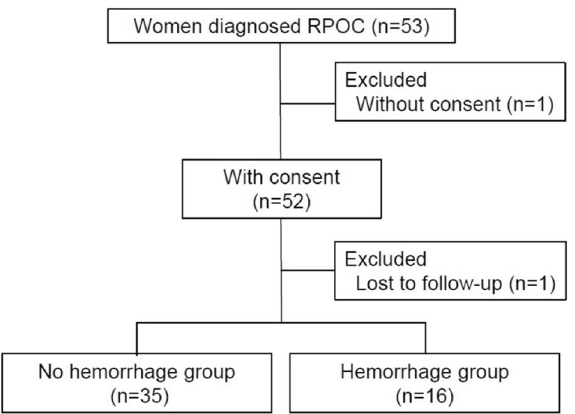
Figure 1. Patient flow chart. A total of 53 women diagnosed with RPOC were recruited. Moreover, 68.6% (35/51) of the women did not experience massive hemorrhage (no hemorrhage group), whereas 31.3% (16/51) required intervention for massive hemorrhage (hemorrhage